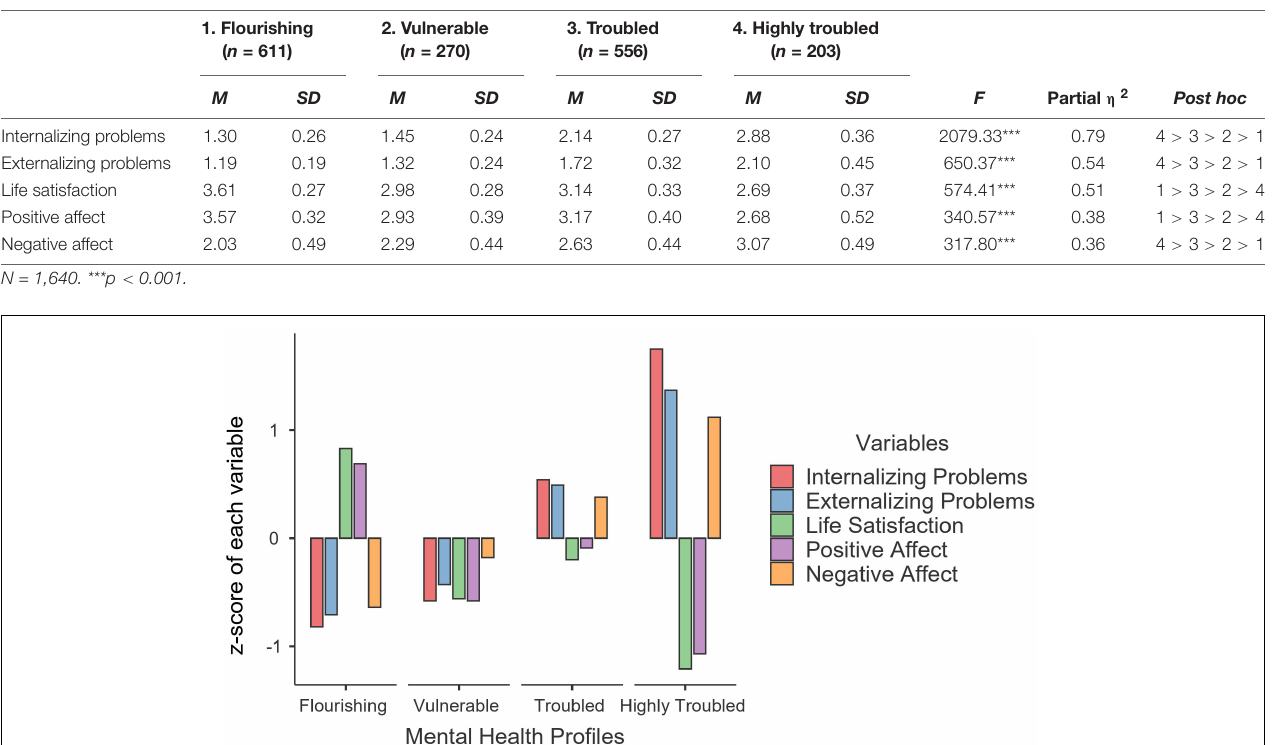
TABLE 3 | Mean differences in study indicators across four mental health profiles.